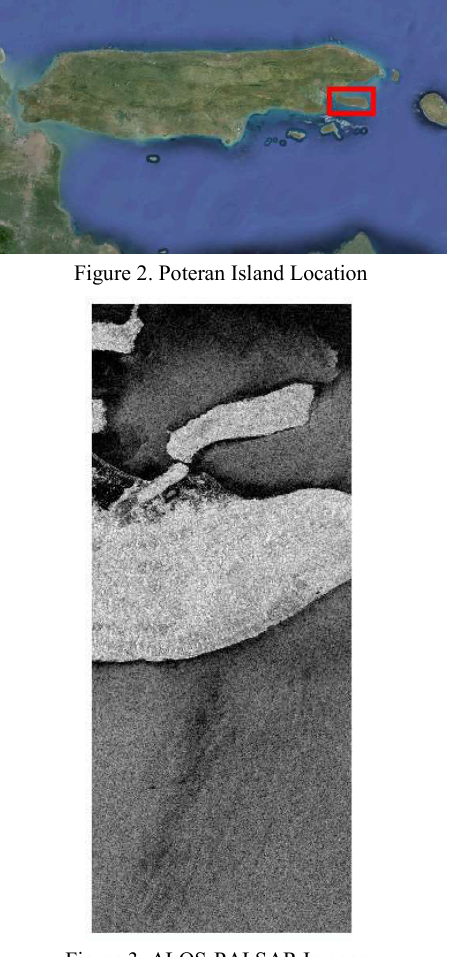
Figure 3. ALOS-PALSAR